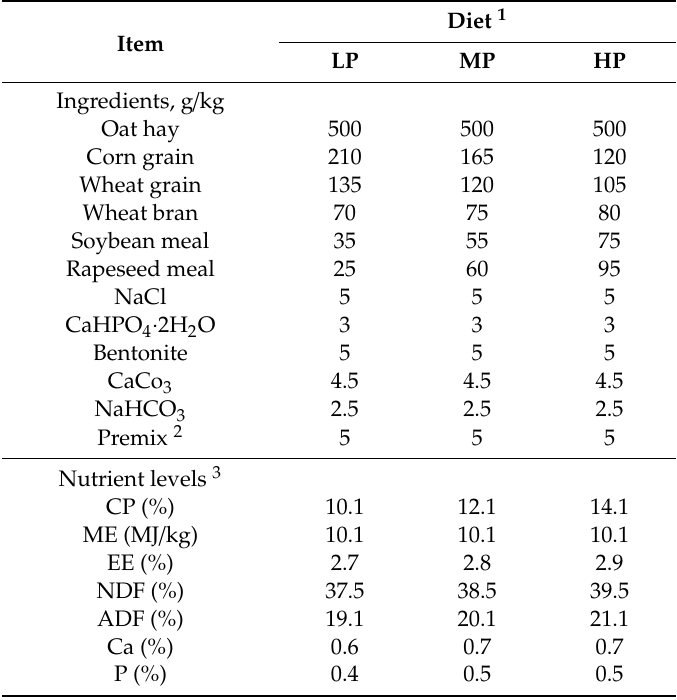
Table 1. Ingredients and nutrient levels of the experimental diets with three di ff erent protein levels (on a dry matter